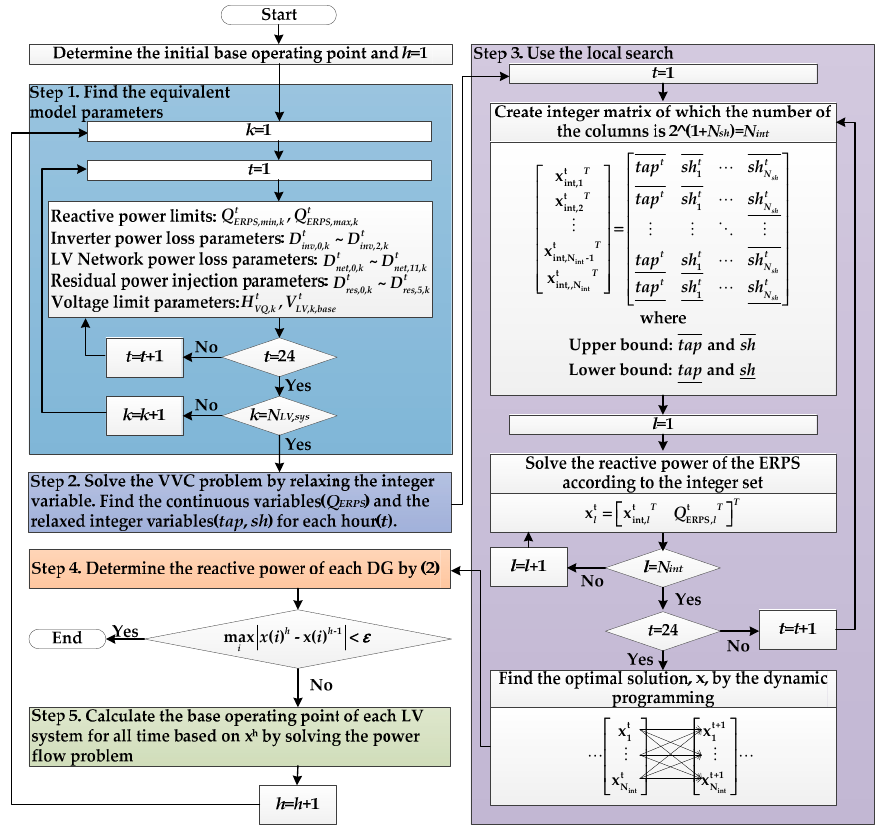
Figure 2. Overall procedure for solving the proposed volt/var optimization (VVO) problem.